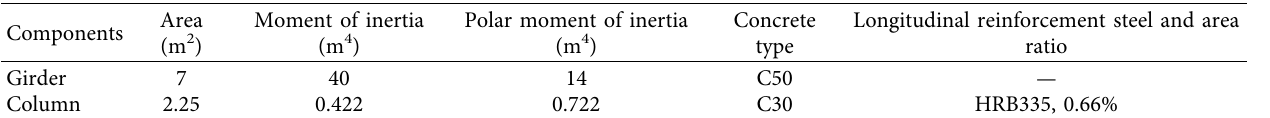
Figure 1: One type of most popular irregular-continuous Table 1: Section properties of girder and piers.